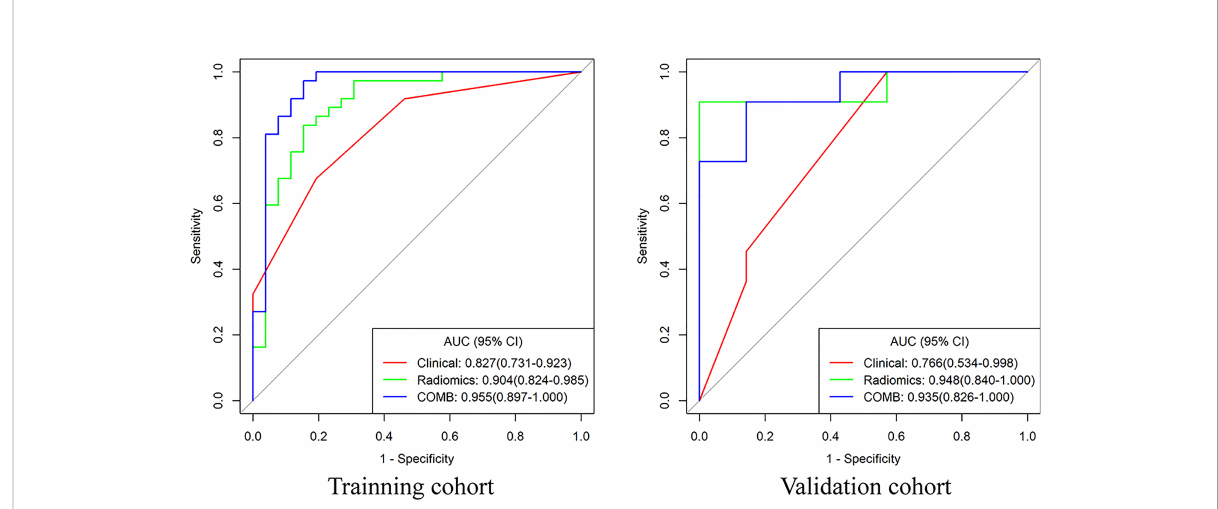
FIGURE 4 The receiver operating characteristic curves of clinical model, radiomics and nomogram for distinguishing BEOT from early-stage